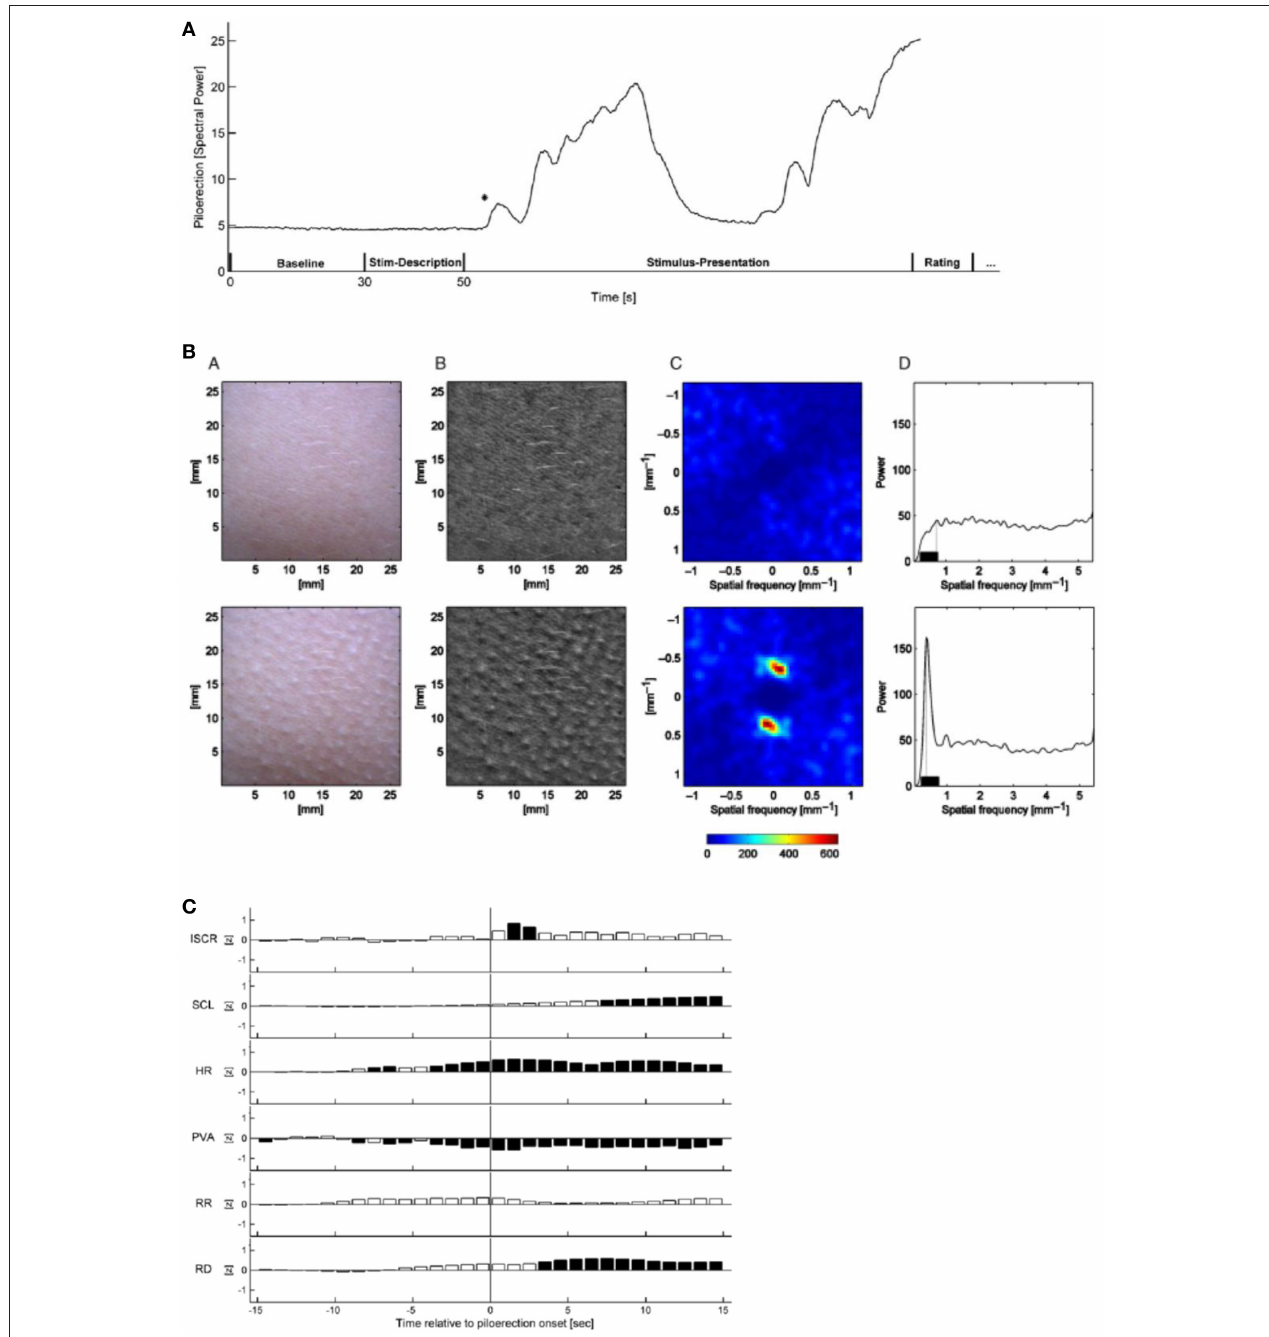
FIGURE 15 | (A) Time-dependence of the relative piloerection intensity of a single experiment, including a baseline period (30s), stimulus description (20s) and stimulus presentation (variable duration). The initial stable level of piloerection intensity indicates no visible piloerection. In this experiment, piloerection occurs shortly after the onset of stimulus presentation; after some time it fades away. The asterisk marks the first detected onset of piloerection. This time is used for the short-term physiological response (Benedek and Kaernbach, 2011). Reprinted with permission from Benedek and Kaernbach (2011) © 2011 Elsevier. (B) Procedure of piloerection quantification without (top row) and with visible piloerection (bottom row). From B (bottom) a two-dimensional spatial Fourier transform is computed (C, shown for the frequency range ± 1.13 mm − 1 ) which is converted to a one-dimensional spectrum of spatial frequency. The maximum spectral power in the 0.23–0.75 mm − 1 range (D) is considered as a correlate of the piloerection intensity (Benedek et al., 2010). Reprinted with permission from Benedek et al. (2010) © 2010 Wiley. (C) Time dependence of the short-term response of physiological measurements for a time slot of − 15s to + 15s around the first onset of piloerection. Dark bars indicate significant deviations from zero, white bars indicate non-significant deviations. ISCR-integrated skin conductance response, SCL-skin conductance level, HR-heart rate, PVA-pulse volume amplitude, RR-respiration rate, RD- respiration depth (Benedek and Kaernbach, 2011). Reprinted with permission from Benedek and Kaernbach (2011) © 2011